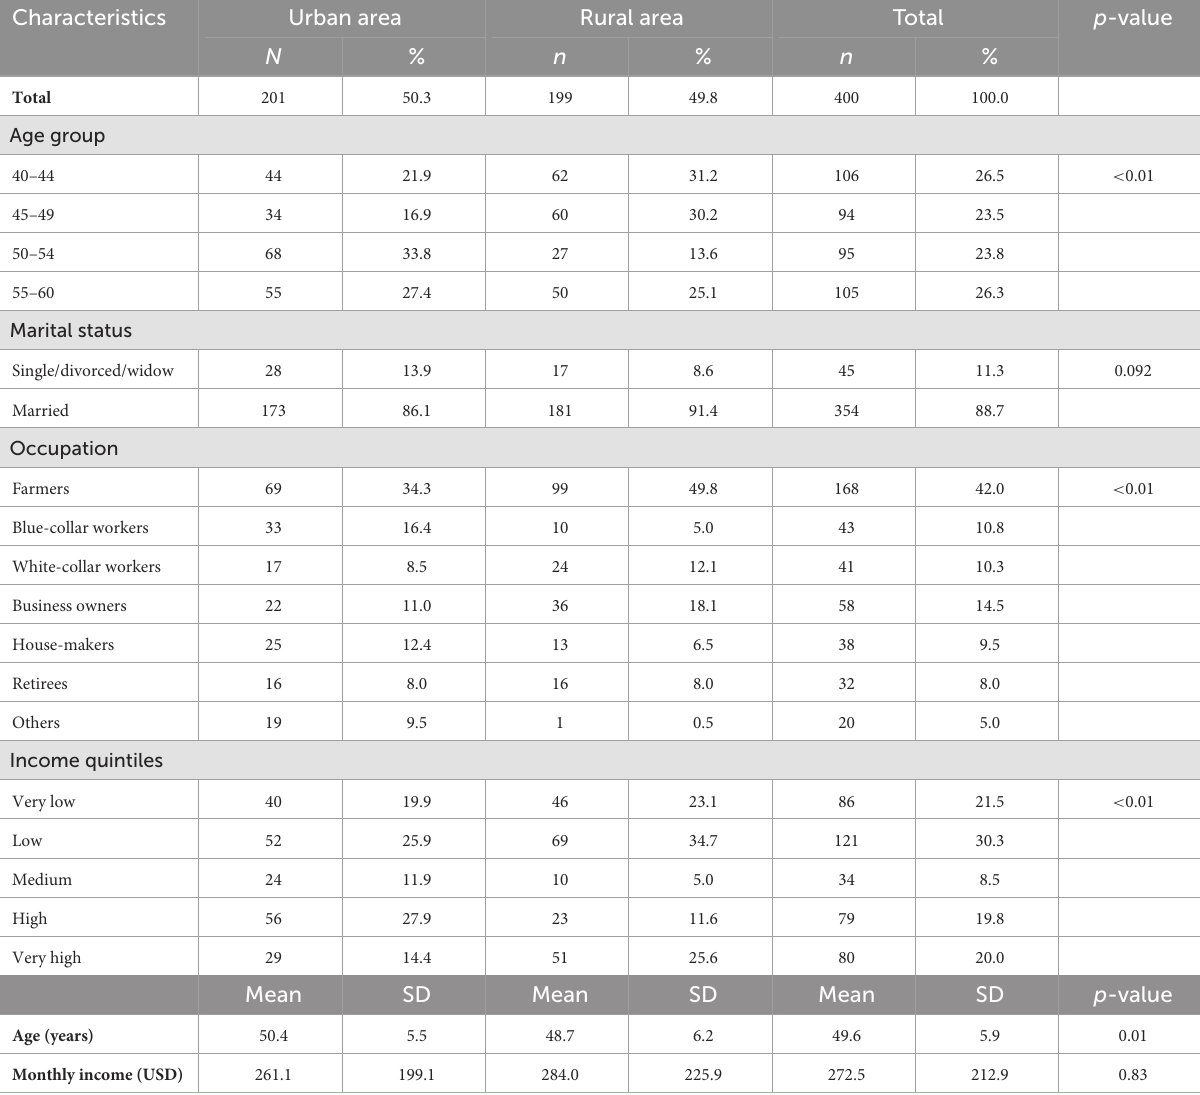
TABLE 1 Characteristics of